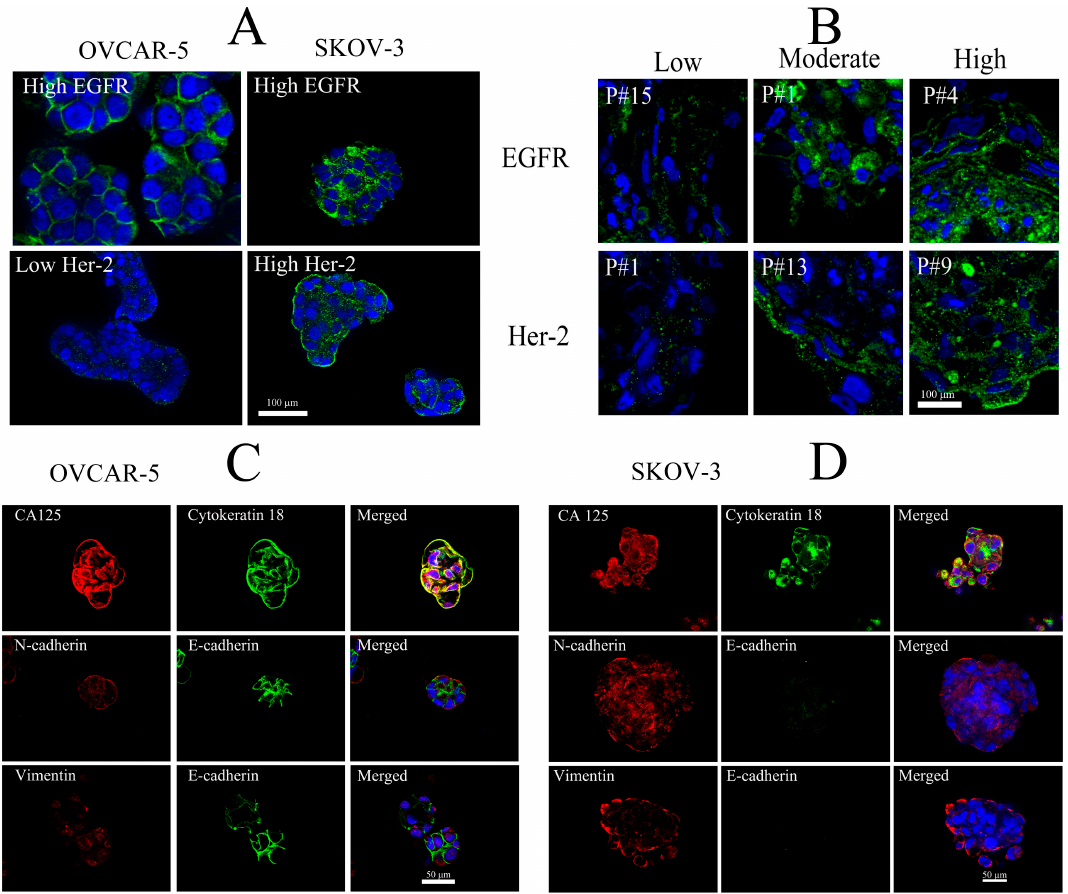
Figure 3. The expression of selected protein markers in ovarian cancer cell lines, OVCAR-5 and SKOV-3, and ascitic fluid derived cells. OVCAR-5 shows a membrane positive staining for EGFR and negative staining for HER-2. SKOV-3 cell aggregates show membrane positive expression of EGFR and HER-2 ( A ). Ascitic fluid-derived cells show positive immunostaining for EGFR and HER-2 ( B ). OVCAR-5 shows positive staining for CA125, cytokeratin-18 and E-cadherin, but low expression of mesenchymal protein markers, N-cadherin and vimentin ( C ). SKOV-3 cell aggregates are positive for the staining of CA125, cytokeratin-18, N-cadherin, and vimentin, but very low for E-cadherin ( D ).